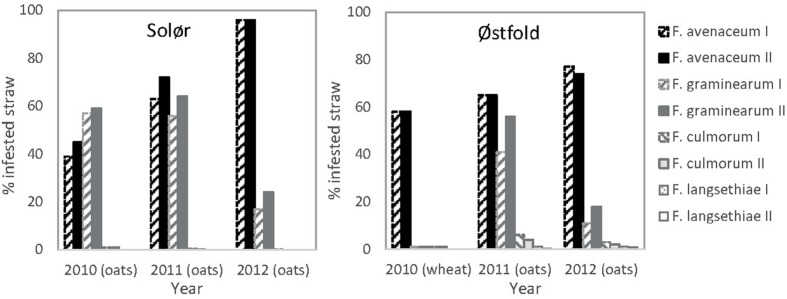
Percentage of straw residues of oats or wheat from the previous years’ crop from which Fusarium was isolated. The residues were collected on the soil surface at sowing at Solør and Østfold in the years 2010, 2011, and 2012. The previous crop is indicated in brackets. Hatched bars represent data from plots where most of the straw was removed in autumn (I). Filled bars indicate that the straw was chopped and retained in the field in autumn (II). The gray tones of the bars relates to the different Fusarium species.